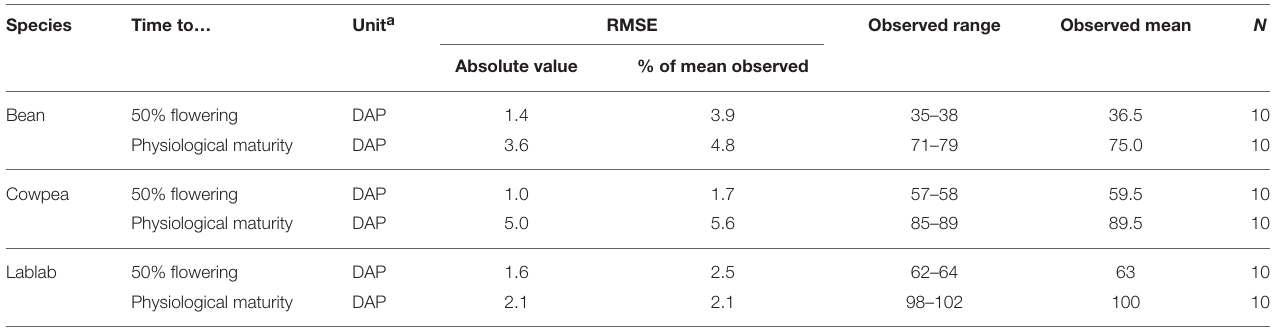
TABLE 9 | Evaluation of the model performance in simulating grain and total biomass of common bean, cowpea, and lablab using statistical criteria (root mean square error, RMSE, and model efficiency, EF) as well as observed range and mean. Species Unit RMSE Observed range Observed mean Absolute value % of mean observed Bean